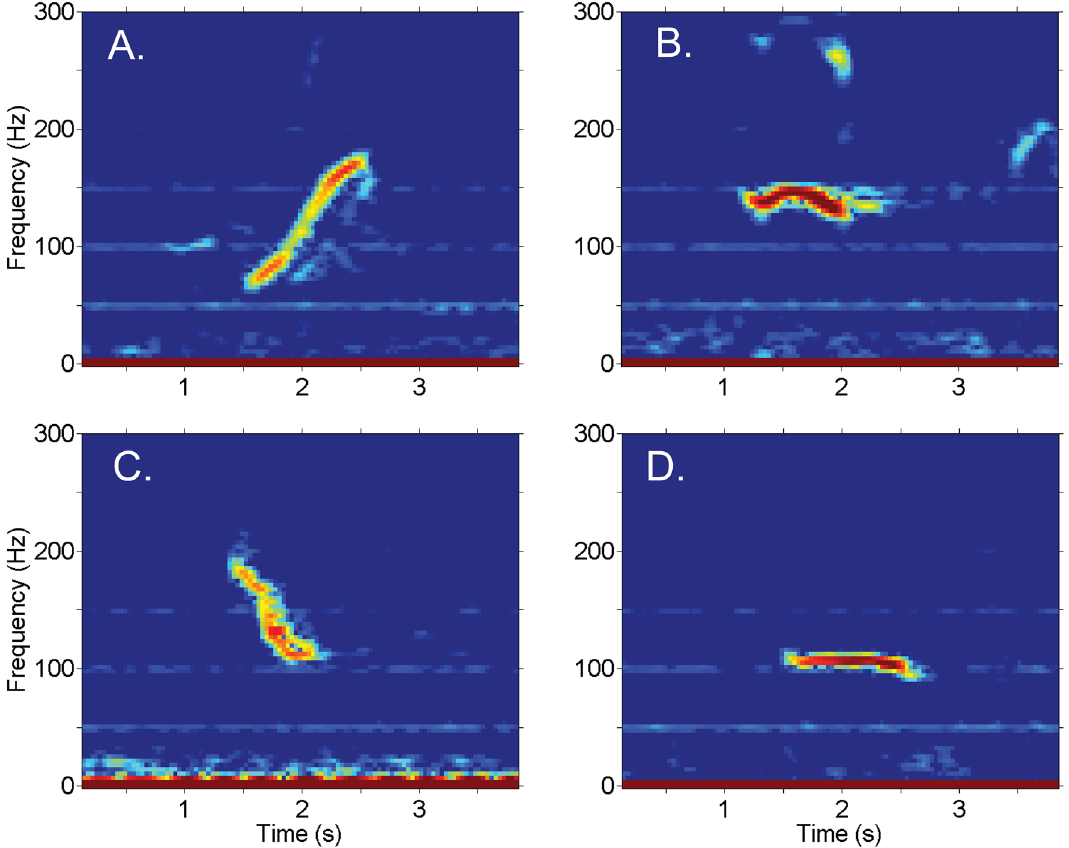
Figure 1. Spectrograms of bowhead FM calls including: ( A ) upsweep, ( B ) undulating n, ( C ) downsweep, and ( D ) constant. Undulating u call type not shown. Sample rate: 2000 Hz, FFT length: 550 samples, window overlap: 87%, window type: